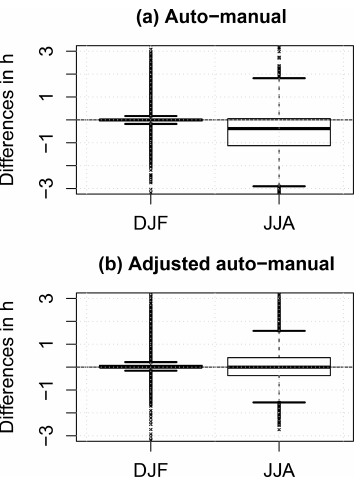
Figure 7. Boxplot of daily differences between automatic and man- ual measurements in hours; left: only winter values are used; right: only summer values are used. (a) raw data is used; (b) adjusted au- tomatic measurements are used.